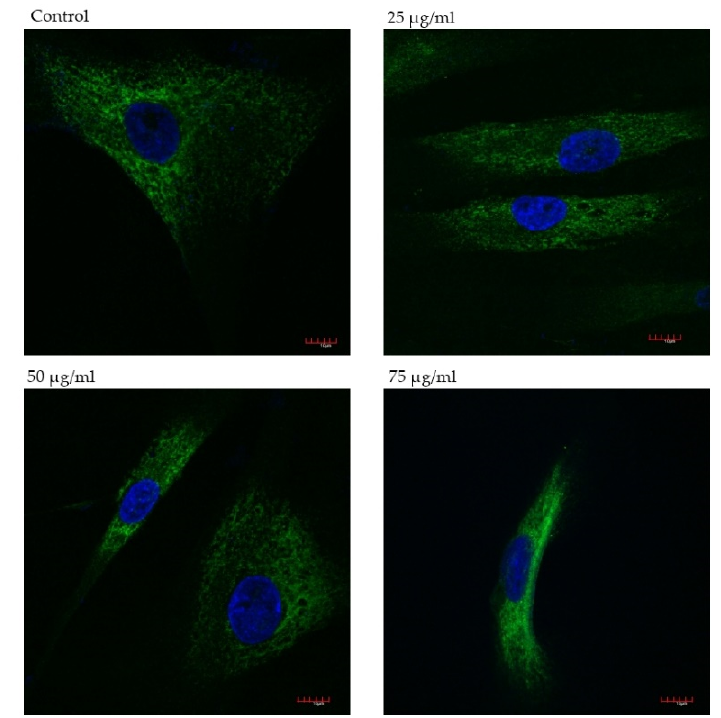
Figure 4. Immunofluorescence staining of collagen type III in fibroblasts after 48 h incubation with salvianolic acid B. Scale bars represent 100 µm.